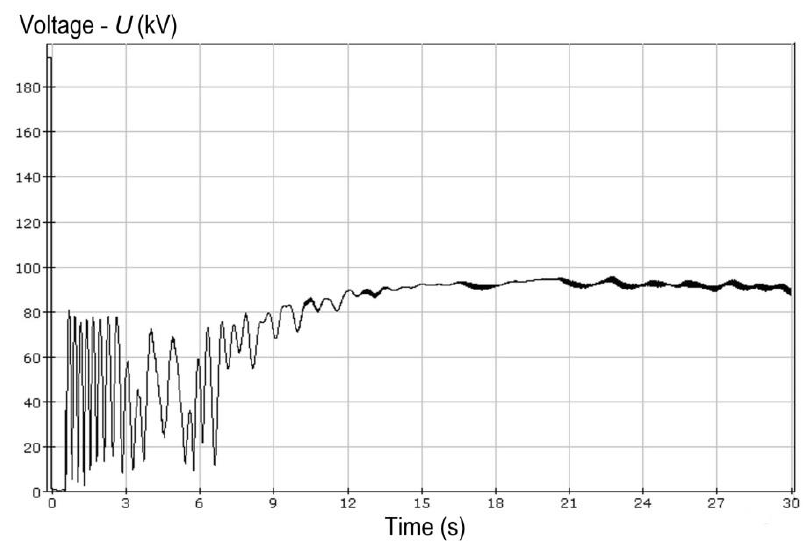
Figure 7. A graph of voltage at buses of the 220 kV CCGTP in a transient process (Figure 6). 3. The probability that the CCGTP out-of-step condition will switch to a multi-ma-